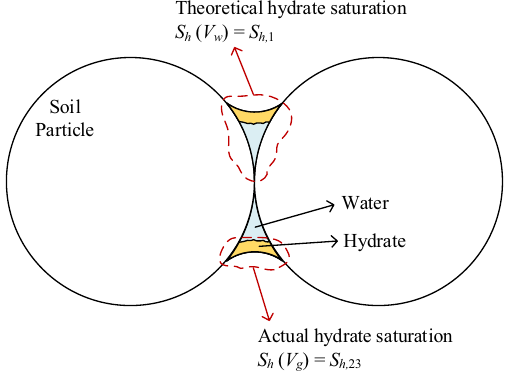
Figure 11. An illustrative difference between the theoretical and the actual S h